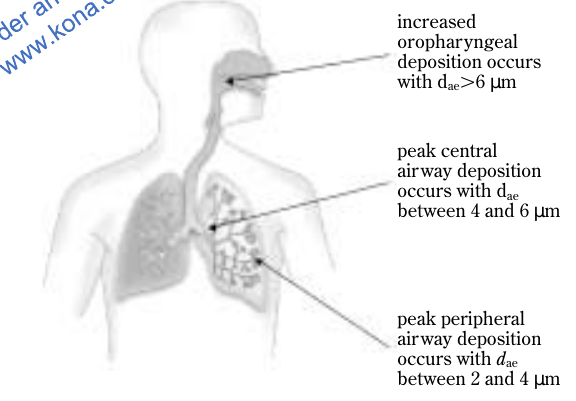
Fig. 1 Deposition of spherical particles of 1 g cm (cid:4) 3 density for slow, oral tidal-breathing by an adult patient (adapted from data in ref.